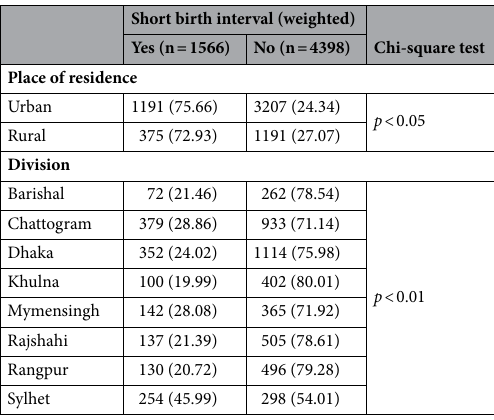
Table 2. Number of births with short birth intervals (weighted prevalence) in Bangladesh by place of residence and administrative division, BDHS 2017/18 (N = 5941). Numbers within the parenthesis are weighted prevalence.